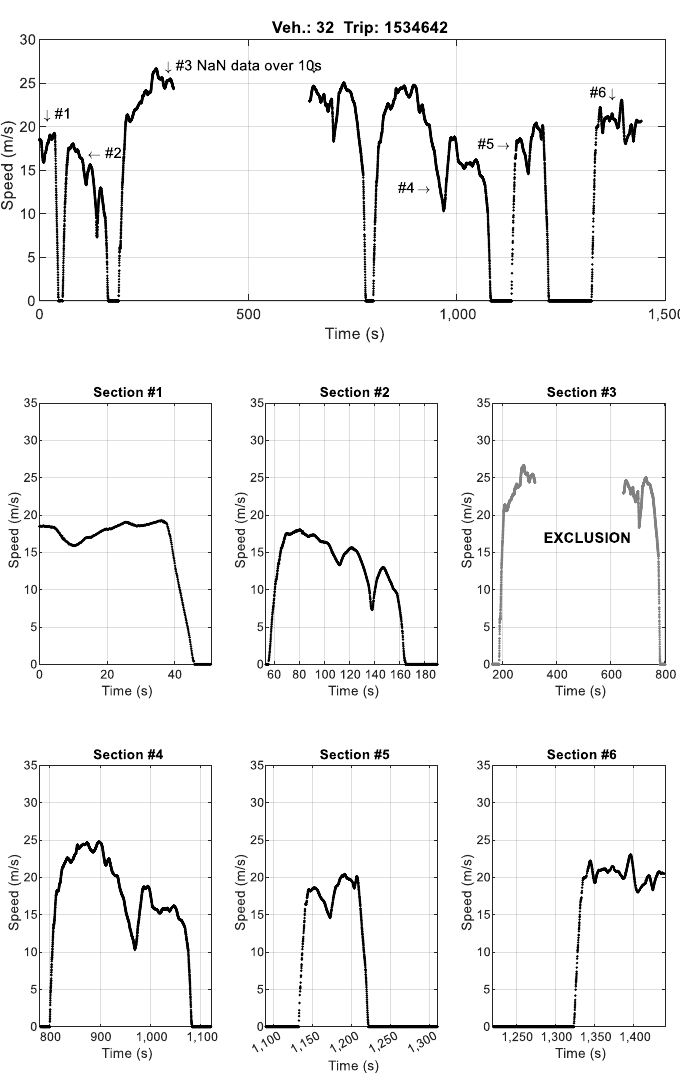
Figure A1. Example of the data exclusion process for the case of SPME driver #32.